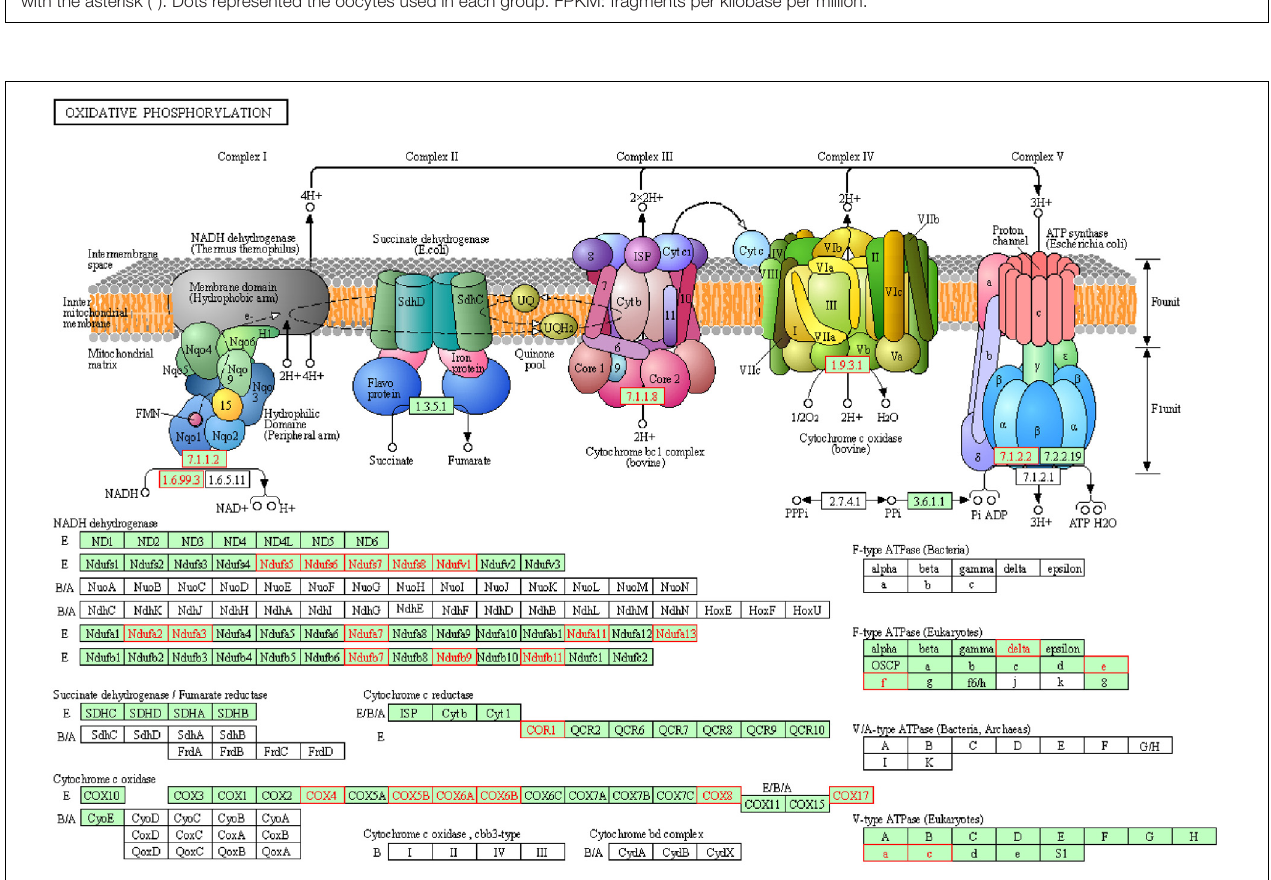
FIGURE 6 | Representative oxidative phosphorylation pathways constructed by KEGG. Red genes represent up-regulated in PCOS oocytes at GV stage.